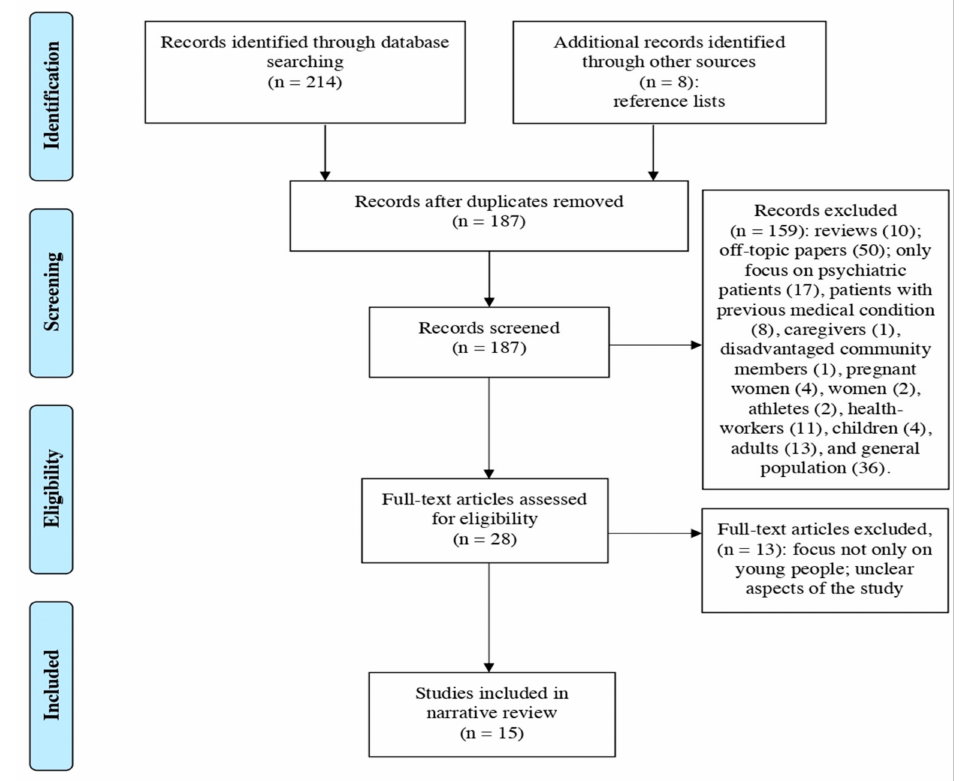
Figure 1. PRISMA Flowchart of the studies selection process for the narrative review on the psycho- logical impact of the COVID-19 outbreak among